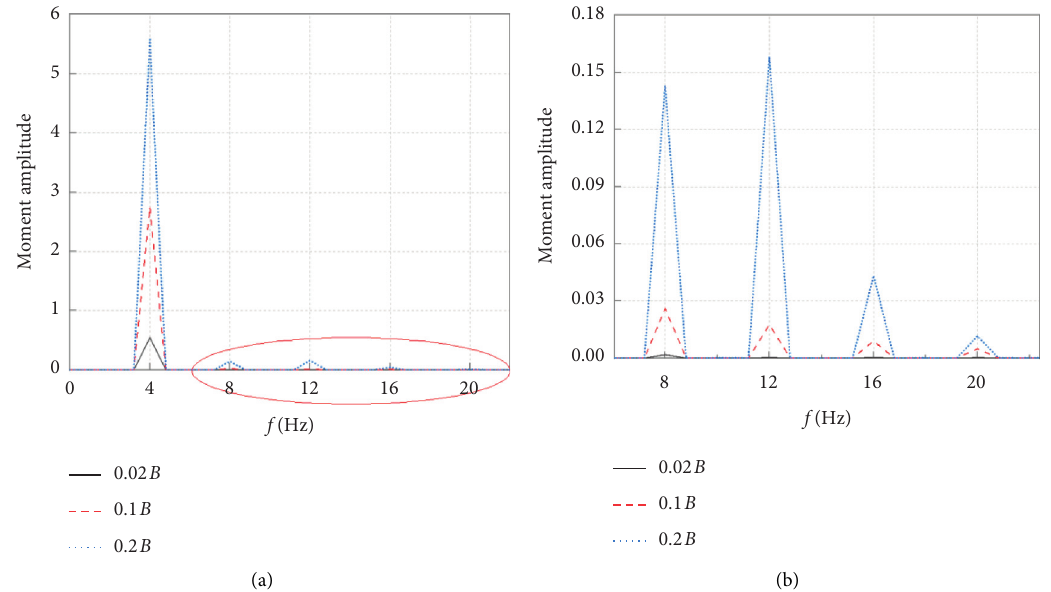
Figure 10: Aerodynamic moment spectrum under different vertical amplitude vibrations of the single frequency. (a) Complete spectrum. (b) Locally amplified spectrum.